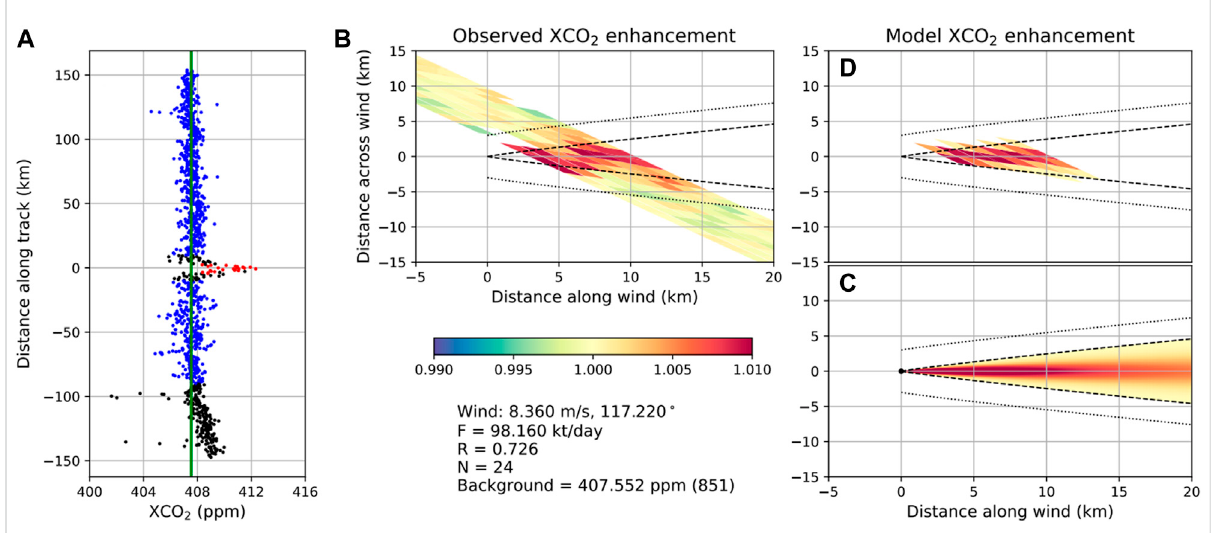
FIGURE 2 CO 2 emission quanti fi cation from the OCO-2 Be ł chat ό w overpass on 2017-03-28. (A) A one-dimensional view of XCO 2 footprint values by collapsing the cross-track direction to show the enhancement or plume footprints (red), background footprints (blue) and others (black). The backgroundvaluedetermined by averaging all blue points is shown as a vertical green line. (B) Observed XCO 2 relative to the backgroundvalue with thepositive x -axis aligned with thewind direction. (C) Gaussian plume model XCO 2 enhancement with dotted lines denoting aregion between the enhancement and background. (D) Model XCO 2 enhancements as would be observed by OCO-2 and used in the observation-model fi